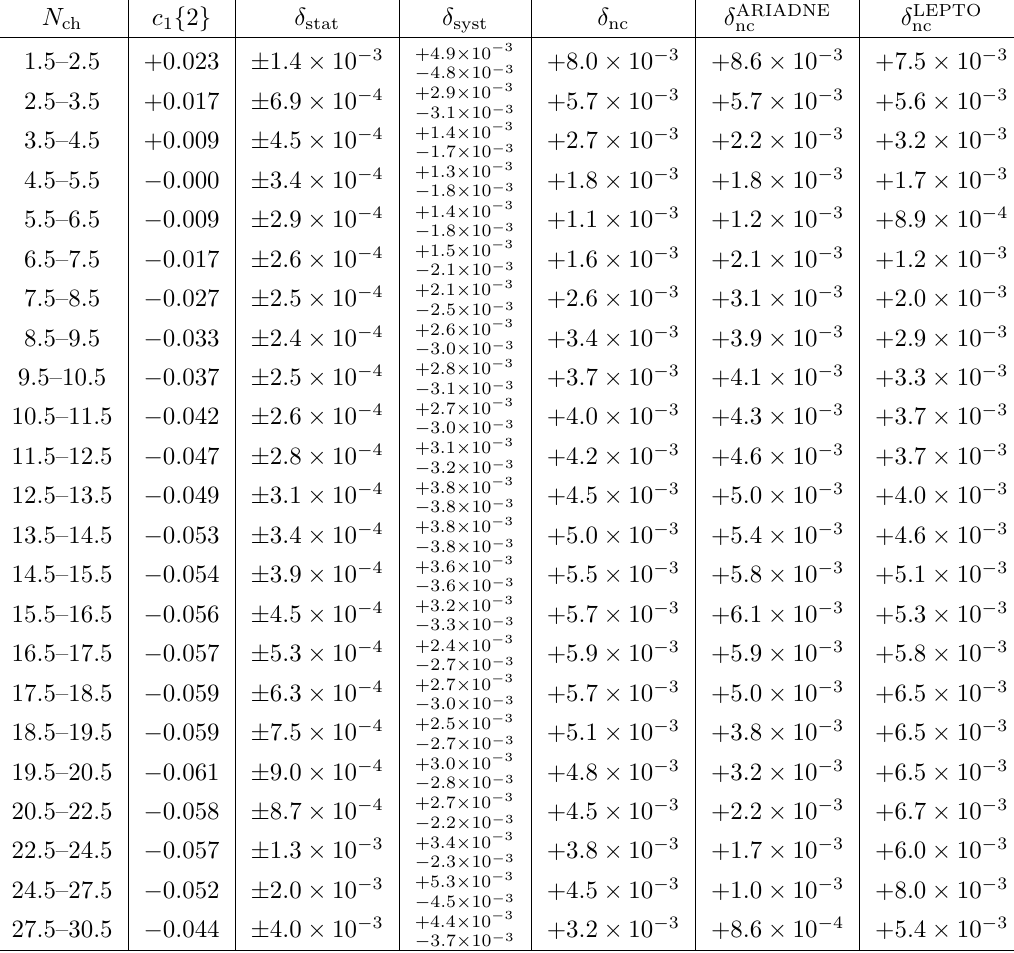
Table 2 . c 1 f 2 g versus N ch from (cid:12)gure 7 (a), p T > 0 : 1 GeV, j (cid:1) (cid:17) j > 2; (cid:14) stat , (cid:14) syst and (cid:14) nc denote the statistical, systematic and Monte Carlo non-closure uncertainties,